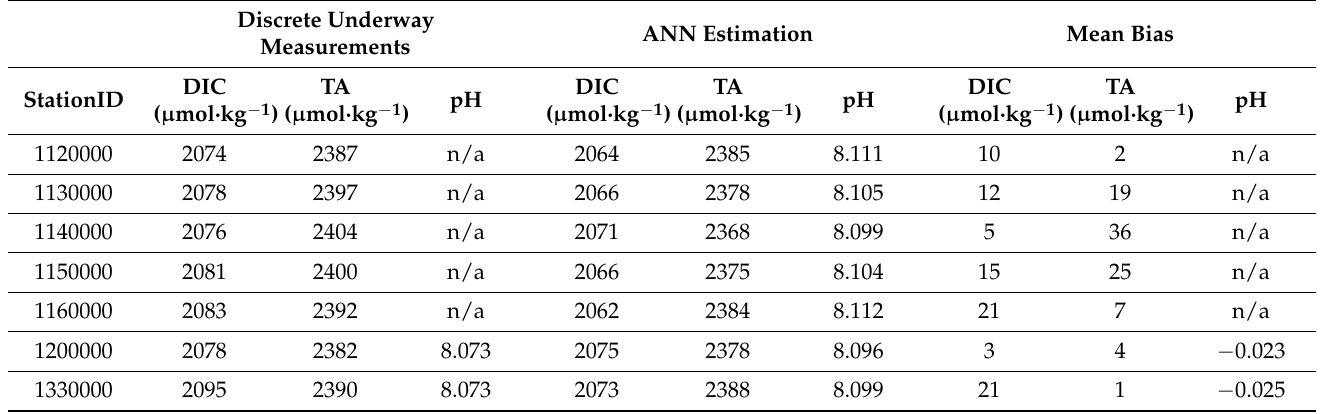
Table 5. Corresponding ship-based and ANN-estimated values for DIC, TA, and pH. In situ pH measurements were not collected by M/V Equinox during part of the transect of 28 April–6 May 2015 (Validation dataset 3). (n/a: not available). The location of the individual StationIDs is as follows: 1120000: (31.1390 ◦ N, − 60.5765 ◦ W); 1130000: (31.3795 ◦ N, − 59.3347 ◦ W); 1140000: (31.7085 ◦